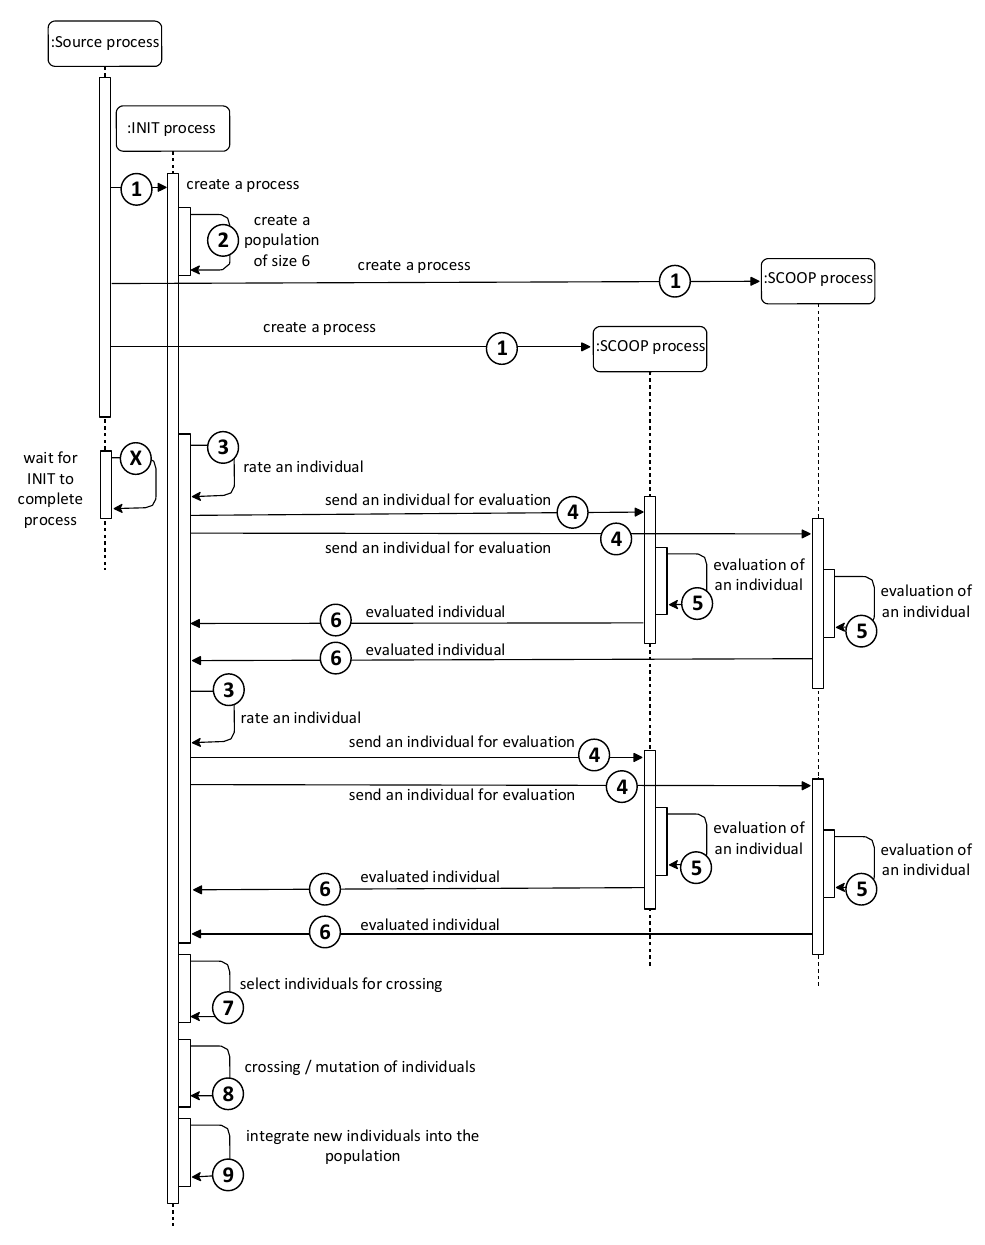
Figure 4. Sequence diagram of one iteration of the Master–Slave model with 2 SCOOP processes. The implementation of the Coarse-Grained model algorithm is found in the Python class CoarseGrainedBase. As with the Fine-Grained model, it inherits from the GrainedGe- neticAlgorithmBase class and modifies the course of the classical GA for processing in each node as